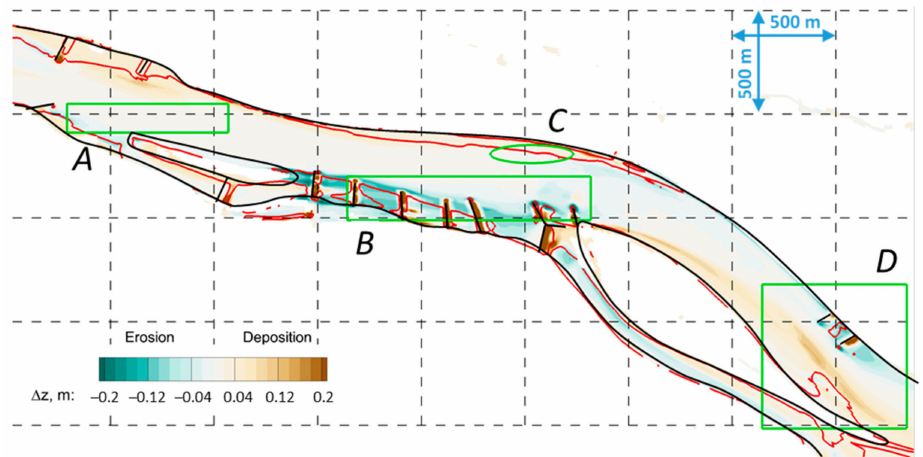
Figure 11. Calculated bed changes by the combined method for the historical flood wave (Figure